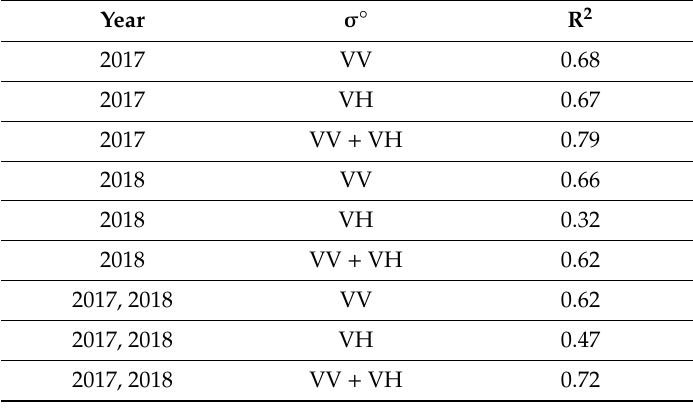
Table 4. Generalized relationship between soil moisture and